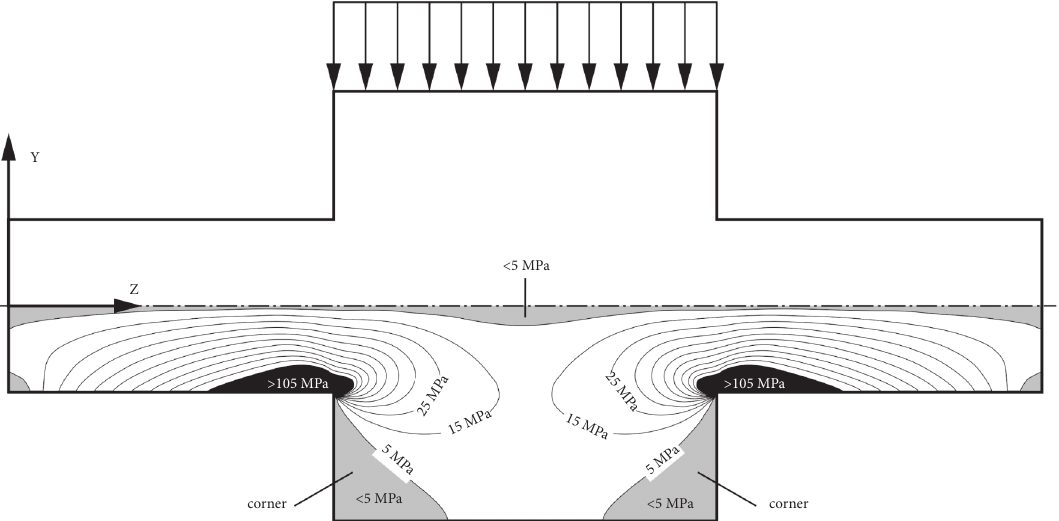
Figure 5: Distribution of σ